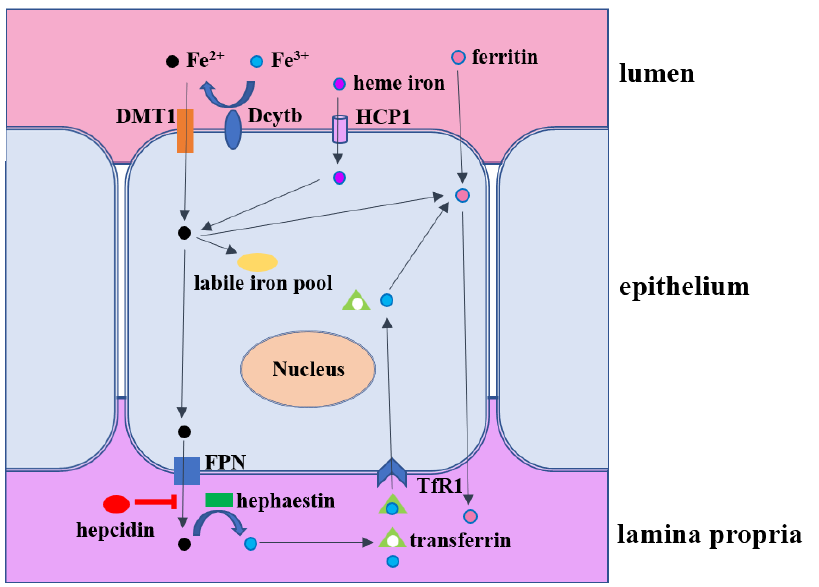
Figure 2. The intestinal iron metabolism. Heme iron is entirely absorbed by enterocytes through heme carrier protein 1 (HCP1). Divalent metal ion transporter (DMT1) can transport Fe 2+ reduced by duodenal cytochrome b reductase (Dcytb). Iron passes through the basement membrane through ferroportin 1 (FPN1) or is stored by intracellular ferritin and the labile iron pool (LIP). Fe 2+ is converted into Fe 3+ by hephaestin (Hp) and then combined into transferrin into the serum. Transferrin receptor 1 (Tfr1) expressed in the intestinal epithelium is able to facilitate cellular iron acquisition by binding to and internalizing iron-loaded transferrin. FPN1 is controlled by hepcidin to induce internalization and the subsequent degradation of ferroportin to regulate iron output. Furthermore, ferritin has been found to be able to pass through intestinal epithelial cells independent of DMT1 channel or heme transporter